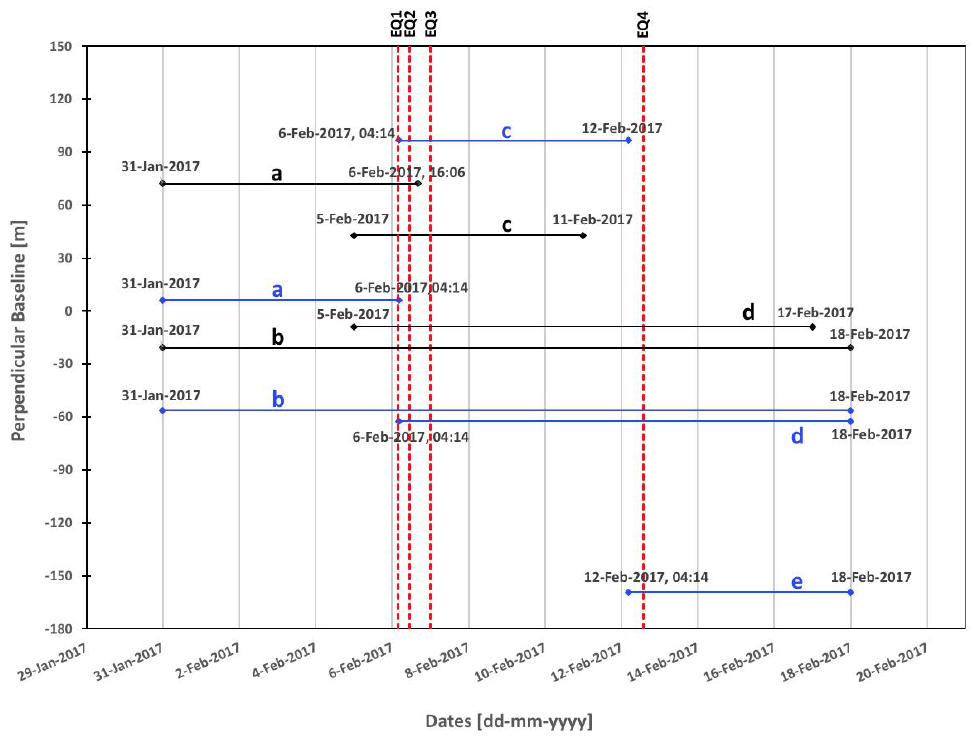
Figure 2. S1 interferograms from the descending track 36 (blue lines) and the ascending track 29 and 131 (black lines). Acquisition dates are plotted over the line ends. Y-axis shows values of the perpendicular baseline (antenna separations) in m. The red dashed lines denote the four major earthquakes, noted as EQ1, EQ2, EQ3, EQ4 (Table 1; highlighted in black). Small letters a, b, c, d, e indicate image pairs in Figures 3 and 4. Table 2. S1 interferograms produced to estimate the fault parameters. Acquisition times are in the form yyyy-mm-dd-hh-mm. The satellite tracks are shown in Figure 1.